Question: What direction does the quantity move in — increasing or decreasing?
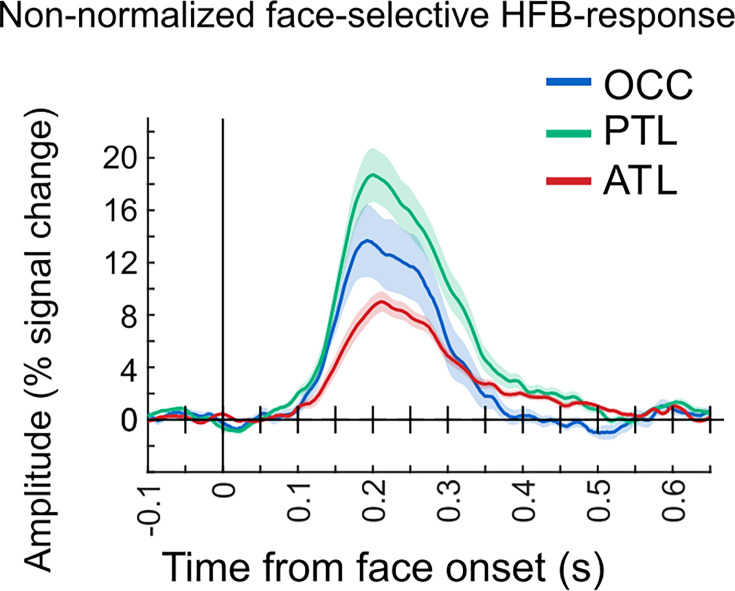
Answer: increasing